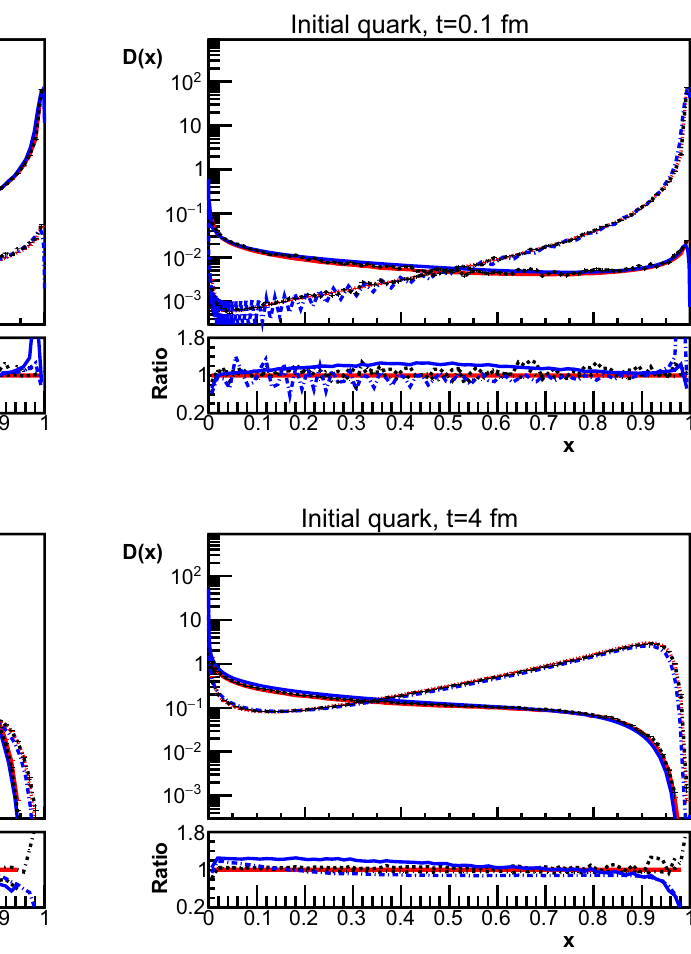
the time-scales t = 0 . 1 and 4fm: cascades initiated by gluons (left) and quarks (right). The bottom panels show the ratios to the corresponding results from